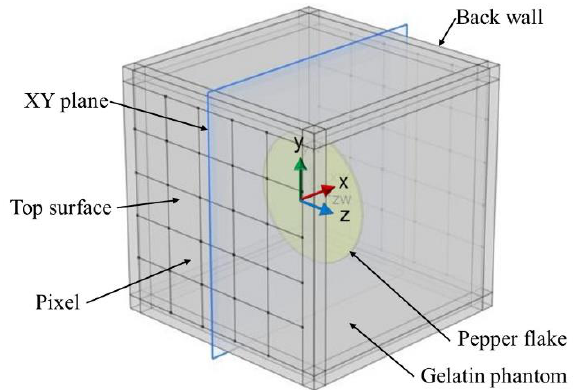
Figure 1. Three-dimensional (3D) model geometry of the gelatin phantom containing the pepper